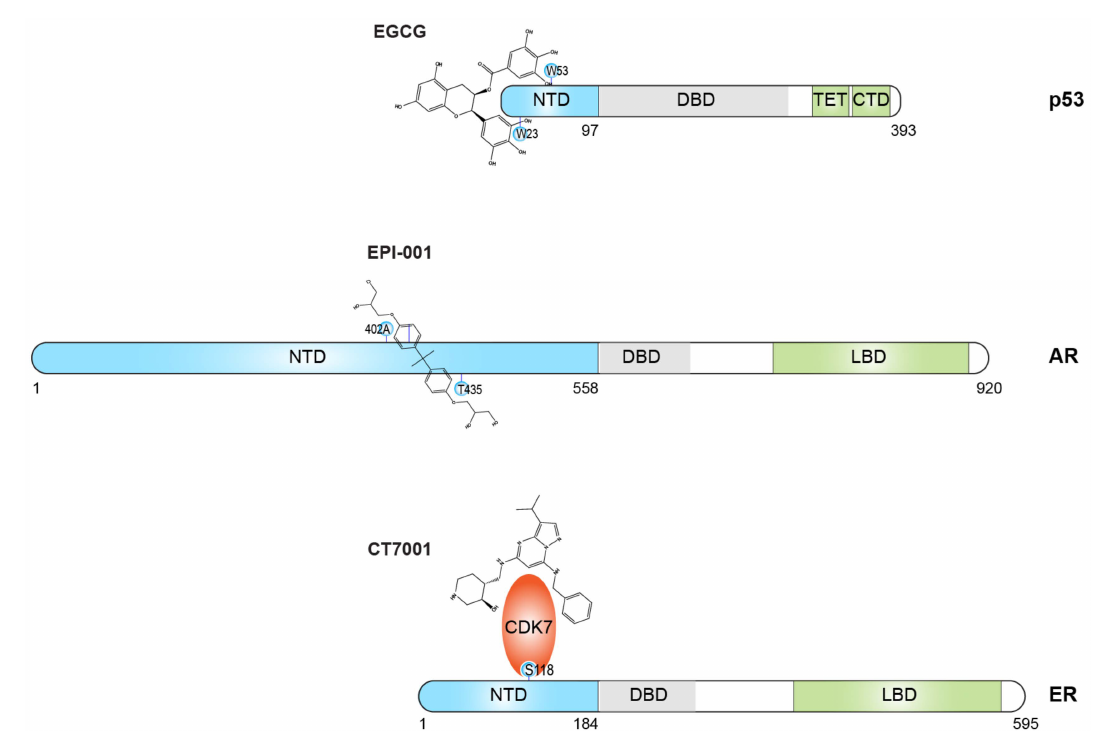
Figure 4. Small molecule targeting against protein intrinsic disorder as a new frontier in drug discovery. NTD: N-terminal domain; DBD: DNA-binding domain; LBD: ligand-binding domain; TET: tetramerization domain; CTD: C-terminal domain. AR: androgen receptor; ER: estrogen receptor. EGCG, a compound found in green tea, has been shown to interact with two specific amino acids of p53-NTD, W23 and W53 [276]; EPI-001, isolated from marine sponges [283], has been found to interact with A402 and T435 residues of AR-NTD [284]. CT7001 has been demonstrated to bind the ATP-binding site of CDK7 (PDB id: 7B5O [91] and 6Z4X [285]), a serine/threonine kinase that can phosphorylate Ser118 within the ER-NTD